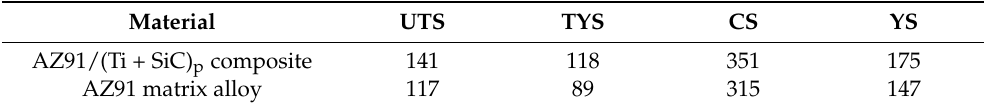
Table 2. Ultimate tensile strength (UTS), yield strength (TYS), compression strength (CS) and yield strength under compression (YS) of AZ91/(SiC + Ti) p hybrid composite compared with unreinforced AZ91 matrix alloy (cast in same